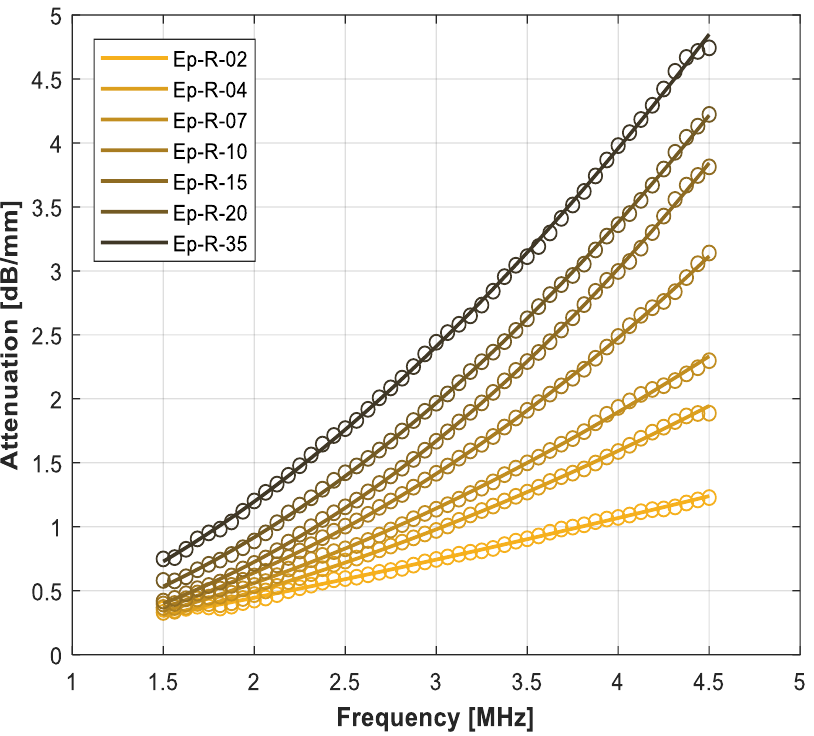
Figure 4. Variation in the ultrasonic attenuation coefficient with the frequency for the rubber-loaded epoxy resin composites. Open circles: measurements. Solid line: fitting using a power law (Equation (1)).